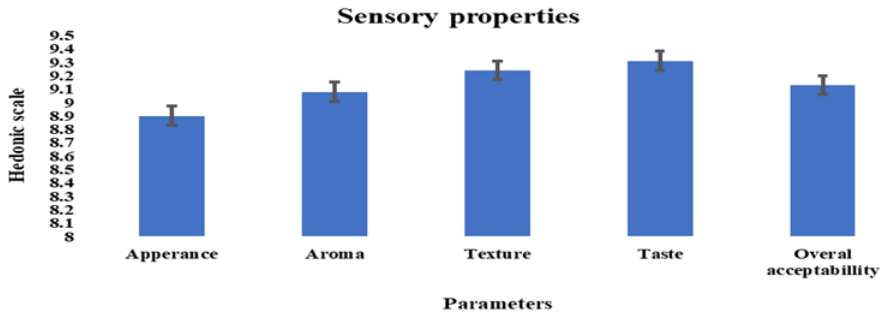
Figure 2. Sensory properties evaluation of fermented soymilk.